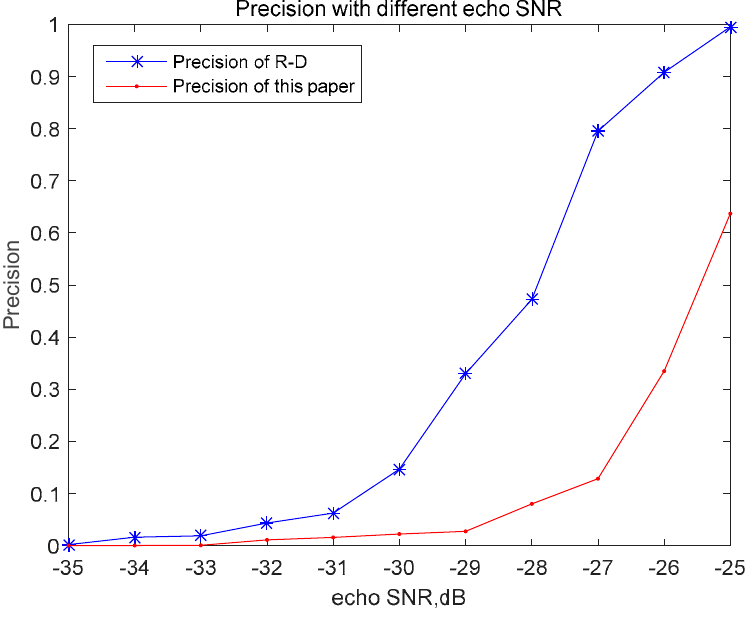
Figure 13. Precision of target detection with different noise power values ( N = 10 4 ): reference SNR = − 10 dB.